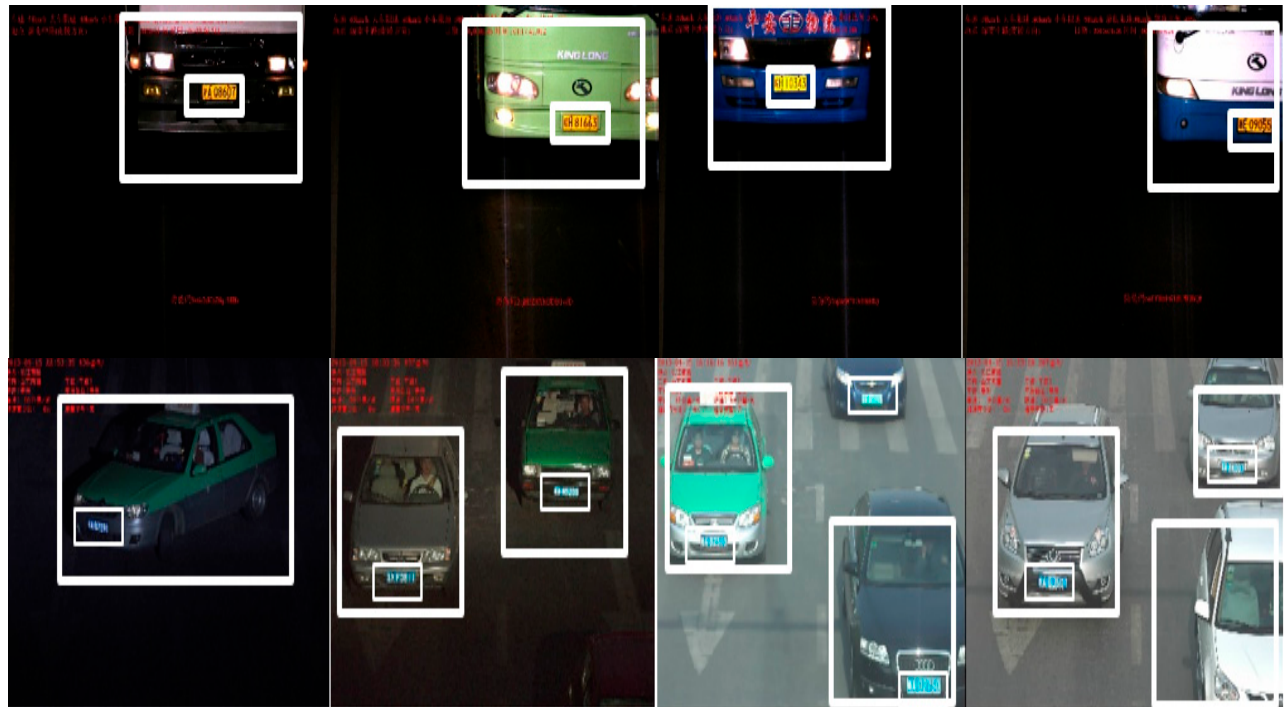
Figure 3. Vehicle+LP detection on PKU dataset.